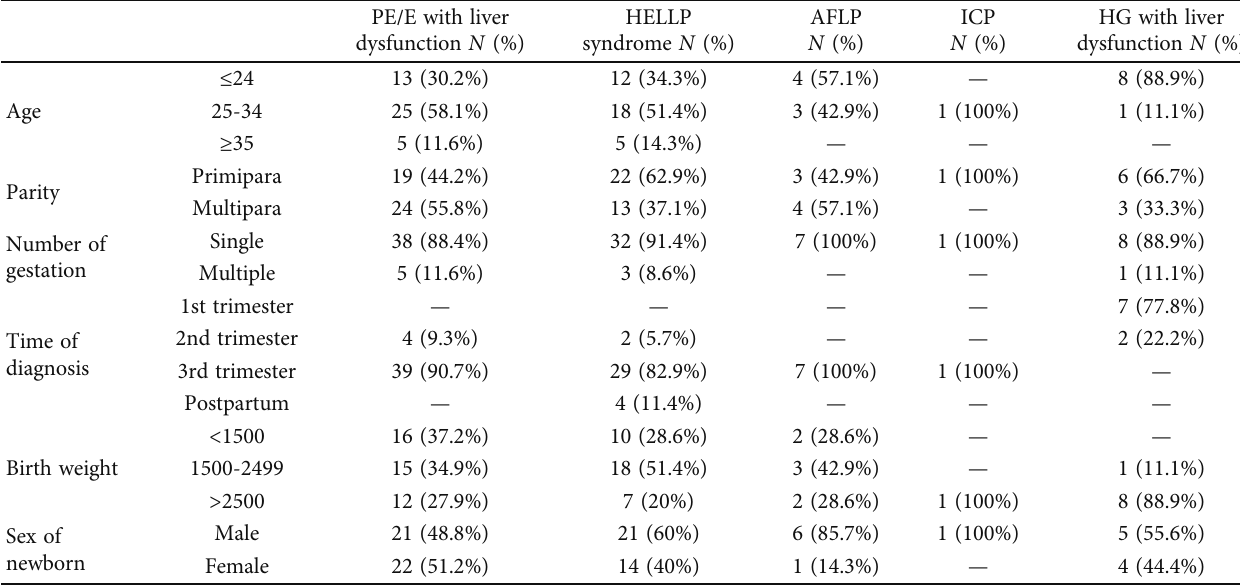
Figure 1: Selection fl ow chart of liver disease unique to pregnancy at St. Paul ’ s Hospital Millennium Medical College. AFLP: acute fatty liver of pregnancy; HELLP: hemolysis elevated liver enzymes and a low platelet; PE/E: preeclampsia/eclampsia; HG: hyperemesis gravidarum; ICP: intrahepatic cholestasis; HBV: hepatitis B virus; HCV: hepatitis C Table 1: Patient demographic and obstetrics characteristics.